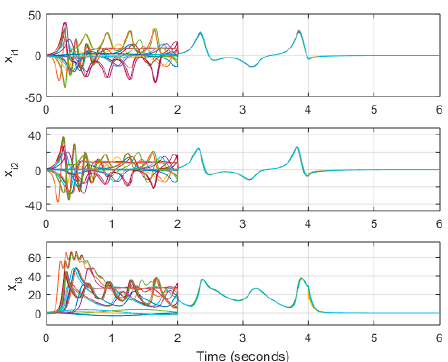
Table 1. Passivity degree values for the different chaotic systems.